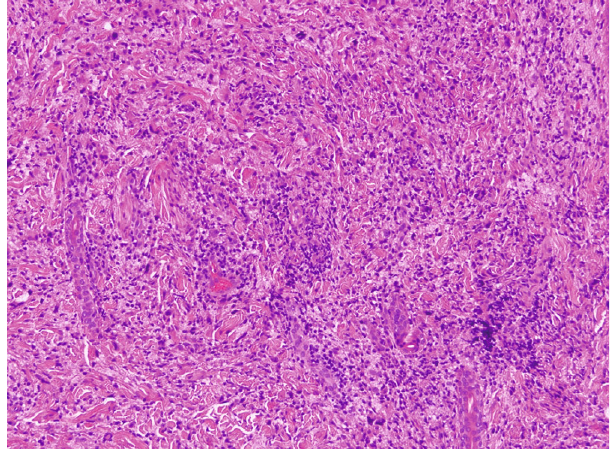
Figure 3: Higher-power view revealed predominantly foamy tissue macrophages with a minor admixture of plasma cells, lymphocytes, and scattered multinucleated giant cells. H&E × 100.